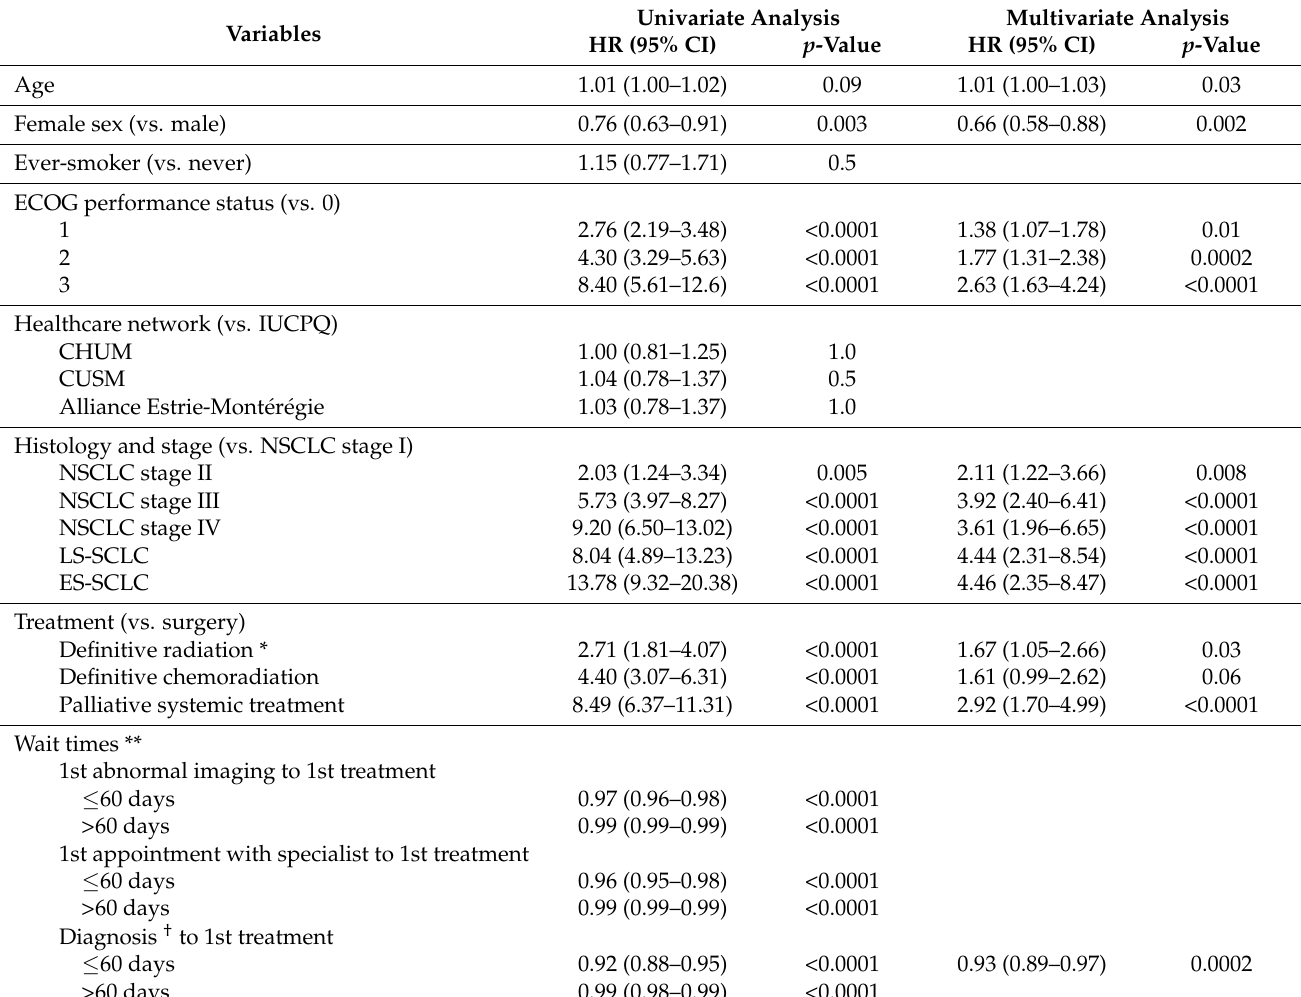
Table 4. Overall survival model ( n =